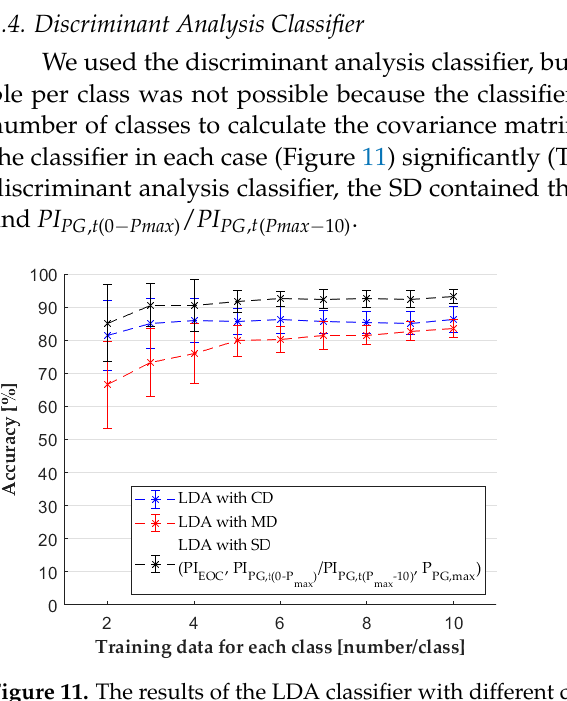
Figure 11. The results of the LDA classifier with different datasets.